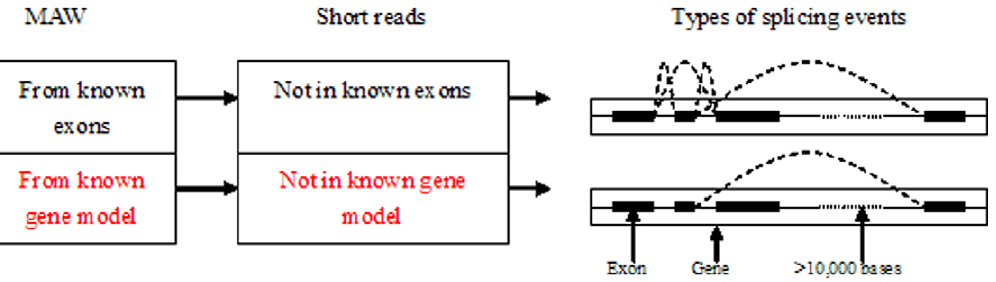
Figure 2. Different types of MAWs, the corresponding short reads and the splicing events that these short reads could identify. Note that these types have the inclusive relationship: MAWs from known exons include those from known gene model; the same for short reads and splicing event. Short reads that are not present in known gene models are likely to correspond to splicing events between distant exons.